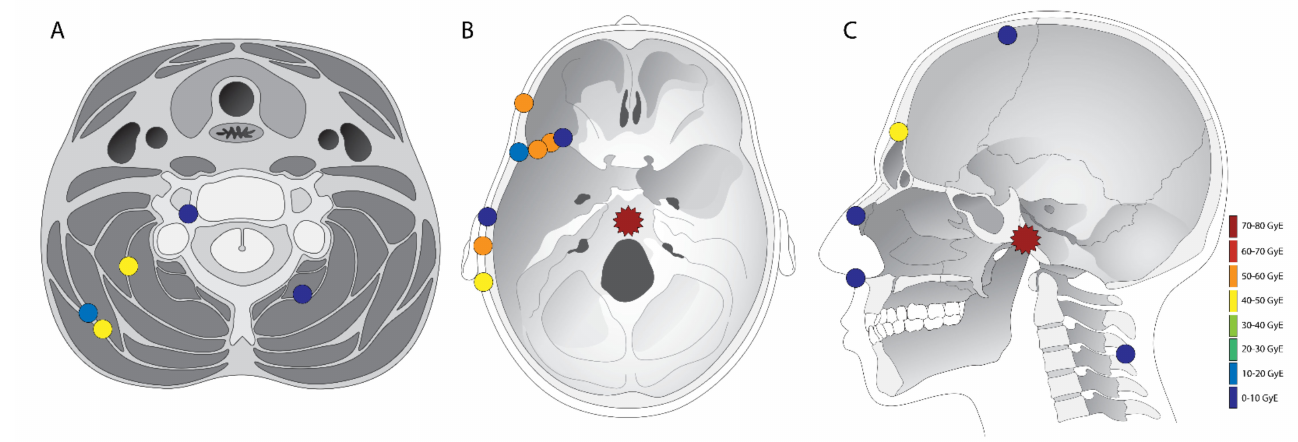
Figure 2. Overview of all defined chordoma lesions. The primary tumor is marked with a star, and ectopic recurrences with a dot. The colour of the markings are an estimation of the dose in GyRBE that was delivered at the site where later the recurrence was visible. All lesions are only marked once in either ( A , B ) or ( C ). The location in the figure is an approximation of the actual recurrence location, so as to fit all the lesions in these three illustrations. However, the compartment of the lesion (subcutaneous, fibrous tissue/muscle, or bone) is accurate.